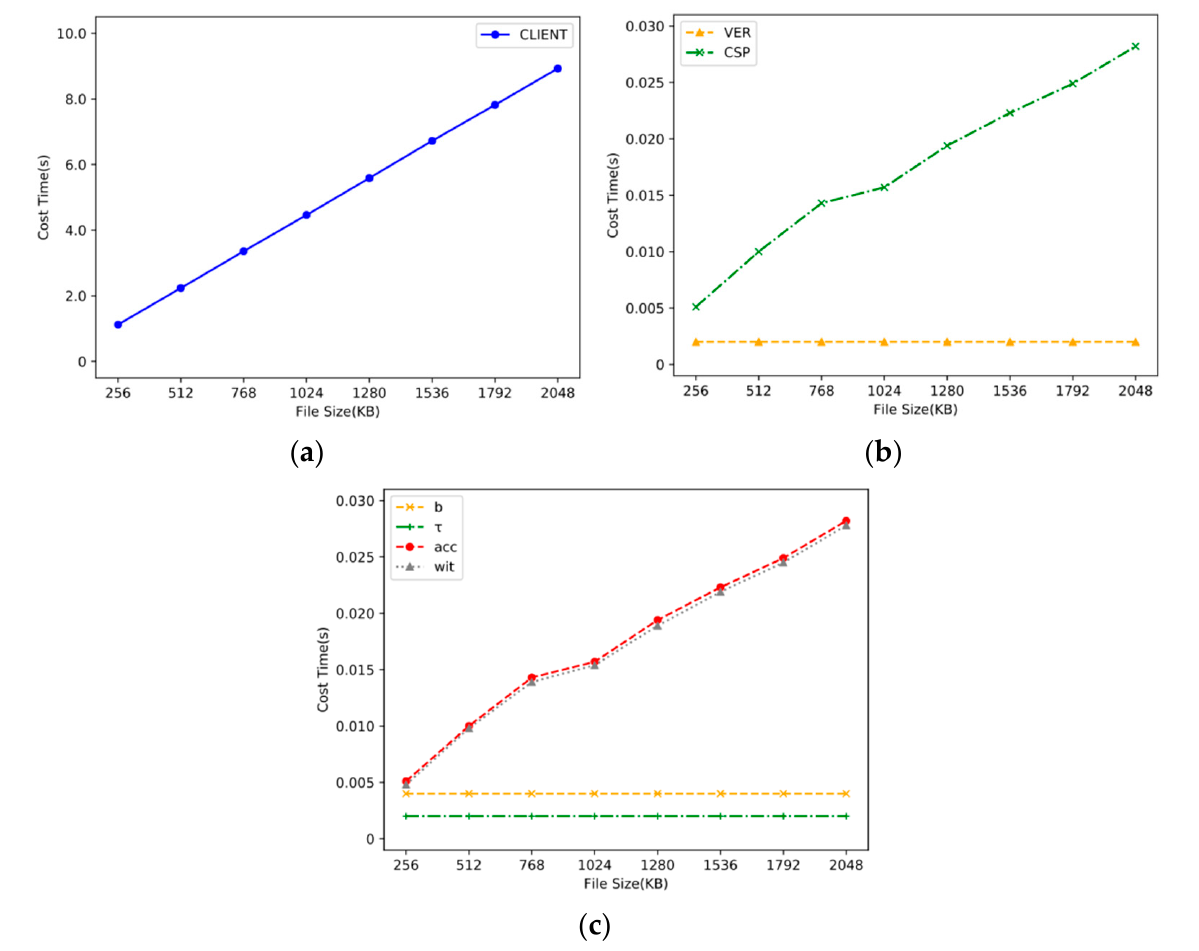
Figure 6. Computing overhead based on different file sizes. ( a ) Computing overhead of audit participants. ( b ) Computing overhead of the client. ( c ) Computing overhead of the parameters.